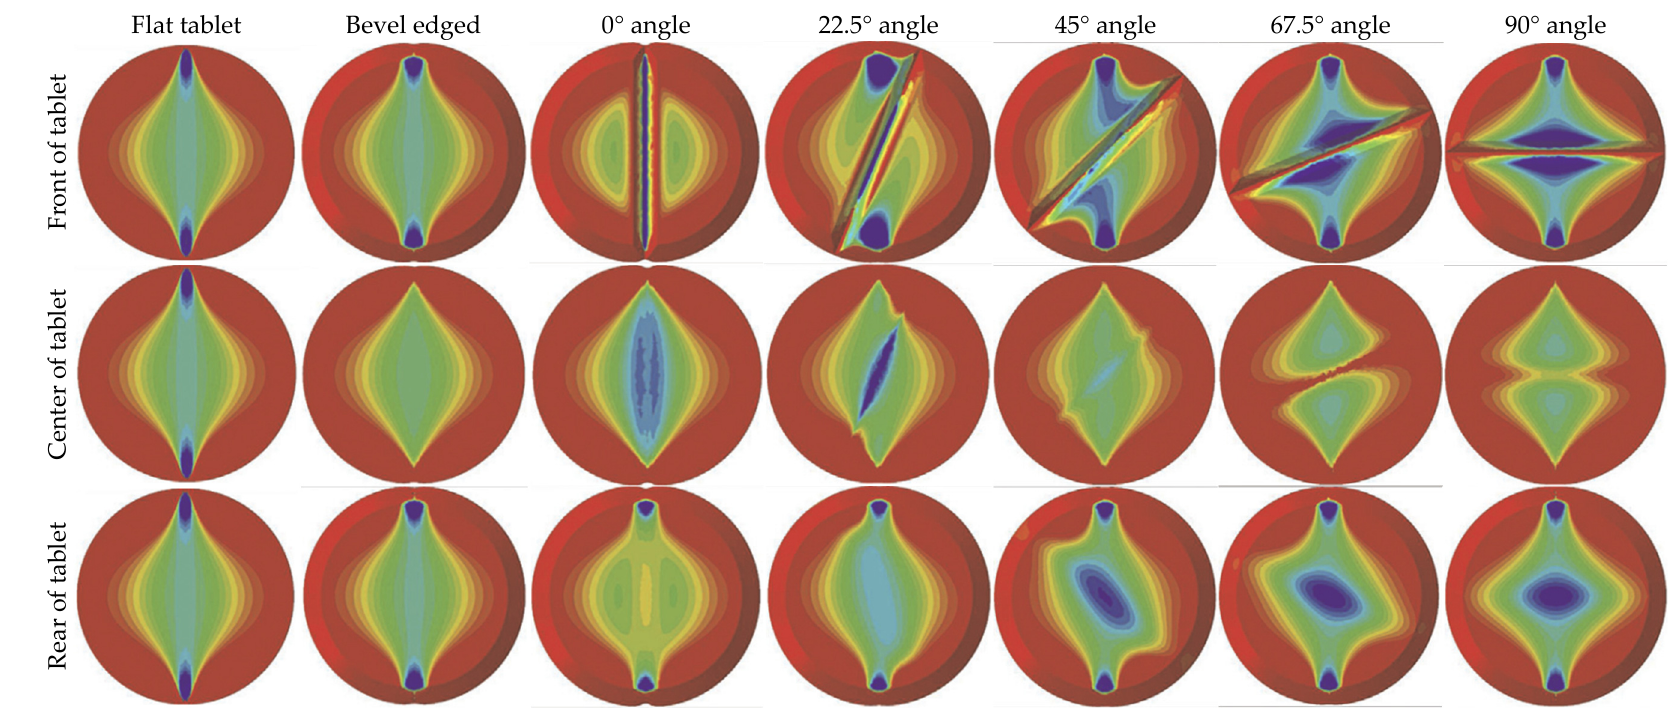
Figure 8. x ‐ axial stress distribution in elastic tablets with breaking (“score”) line (Adapted with permission from Ref. [90] ).